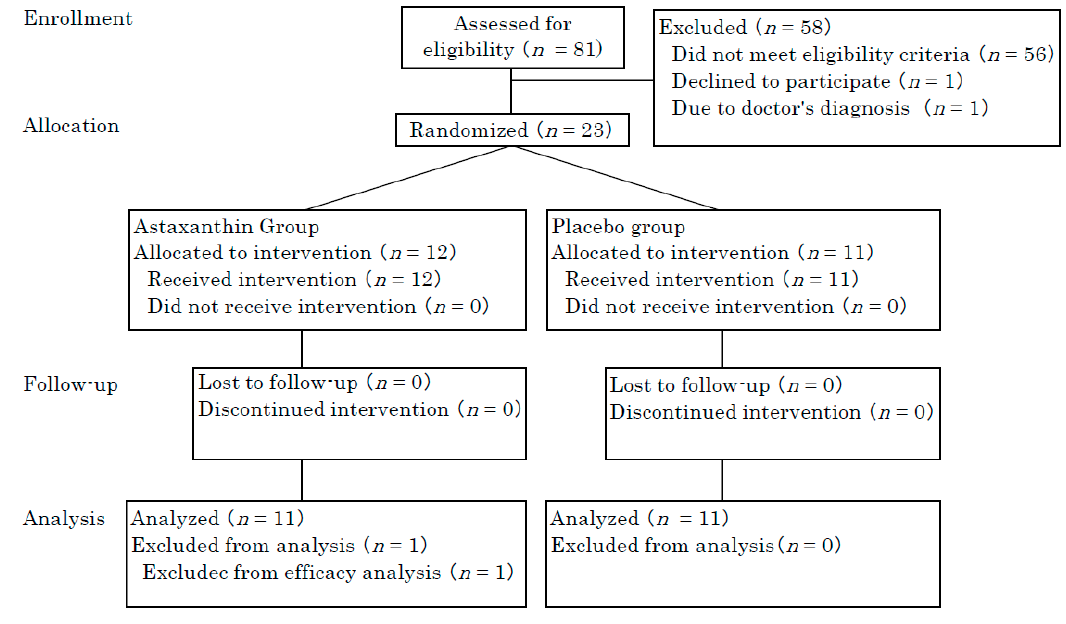
Figure 1. Flow diagram of participants. Table 1. Baseline characteristics of participants who completed the 10 weeks study.